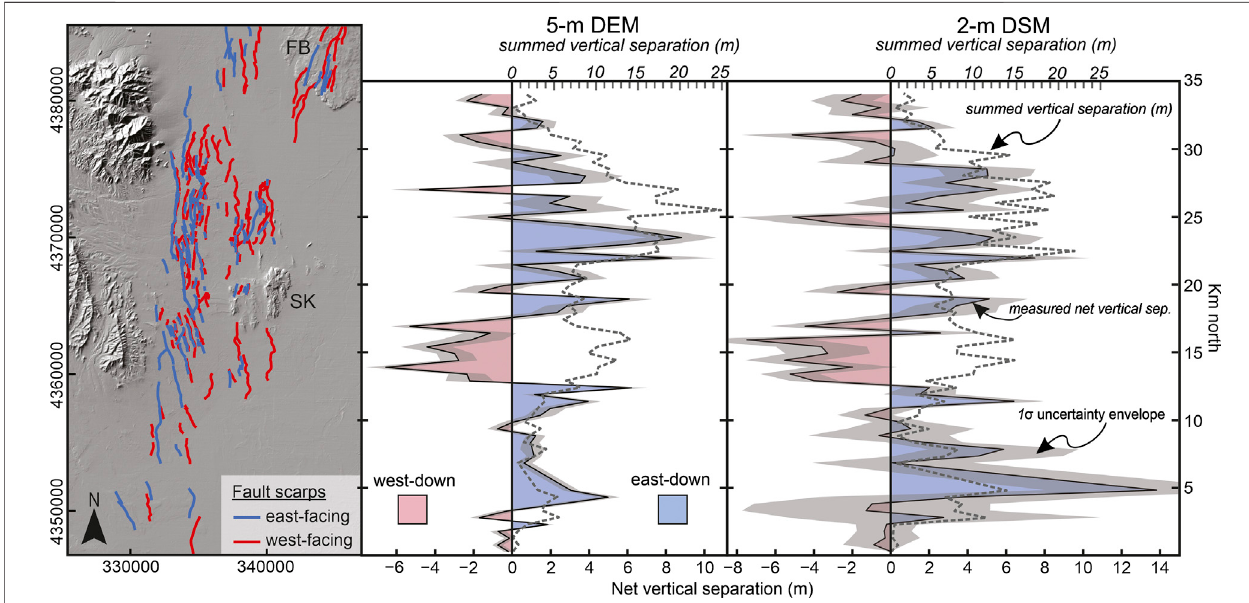
FIGURE 8 | Net vertical separations calculated in 500 m-spaced E-W transects in the 5-m DEM and 2-m DSM. In both the map and graphs, blue indicates east- down displacement (positive) and red indicates west-down displacement (negative). Shaded regions indicate the 1 σ uncertainty of net separations. The results show a net east-down displacement along most of the fault zone, with a maximum of c. 10 m — which is evident in the 5-m DEM but not the 2-m DSM. Summed vertical displacementirrespectiveofscarpdirectionisshown bythegreydashed line(note differentscaleat topofgraphsingrey).FB – FumaroleButte.SK – Smelter